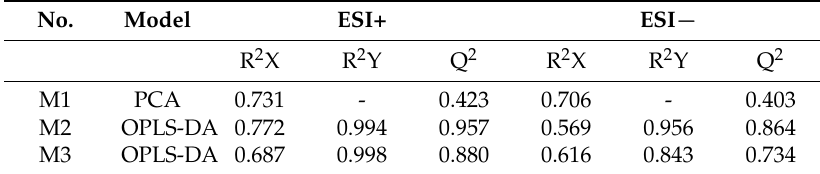
Table 1. Parameters of PCA and OPLS-DA